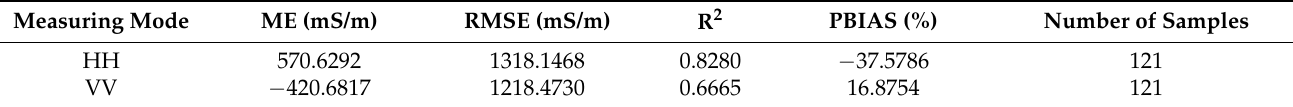
Table 15. Statistical data for accuracy assessment of the RK